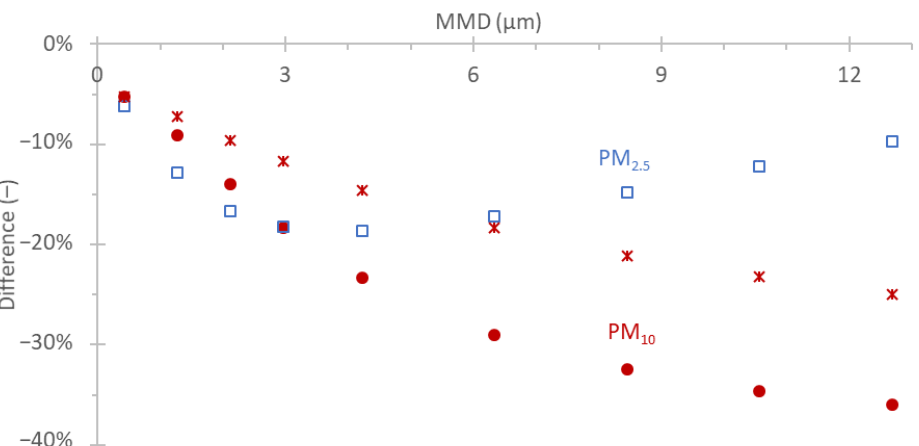
Figure 5. Differences of PM between “max penetration” and “min penetration” setups with cyclonic separators of 2.5 µ m (open squares) and 10 µ m (solid circles). Asterisks give the difference of the two scenarios using the same 10 µ m cyclonic separators. The mass median diameter (MMD) was calculated from the Count Median Diameter (CMD), assuming a geometric standard deviation of 2 (see main text).